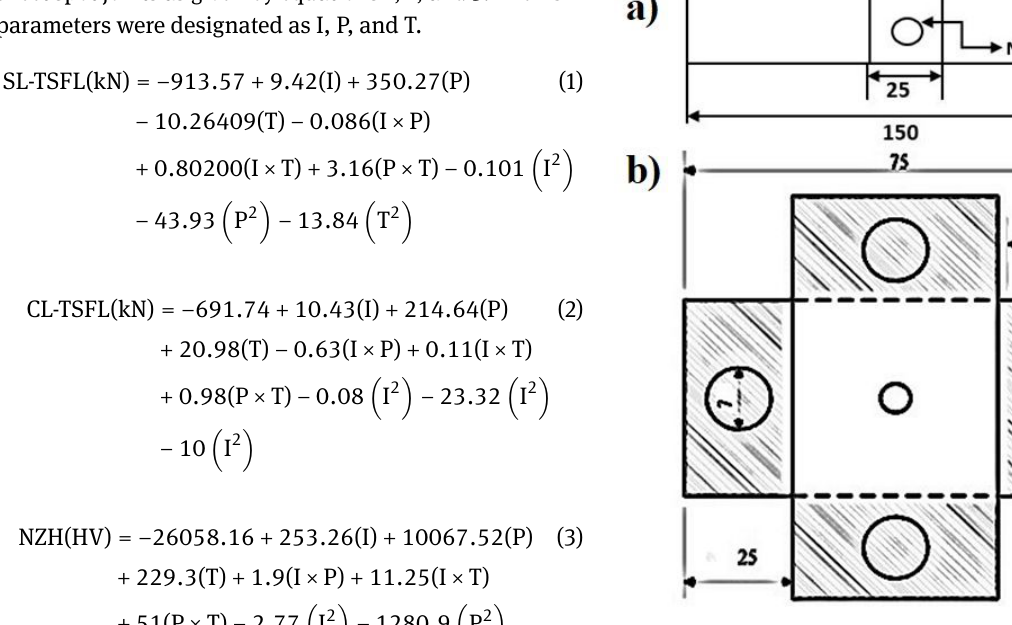
Figure 2: Dimension of TSFL specimens: a) SL-TSFL and b) CL-TSFL